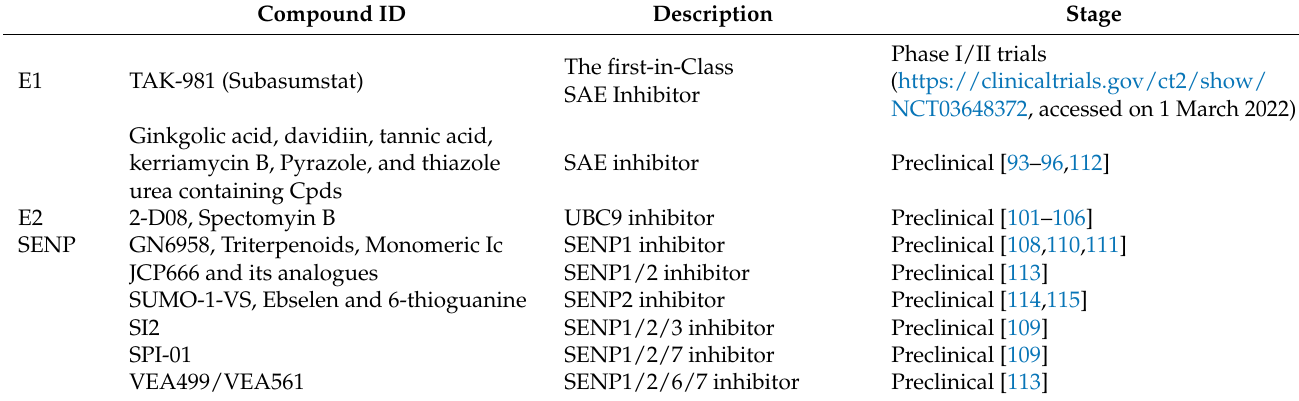
Table 6. Selected inhibitors target in SUMO